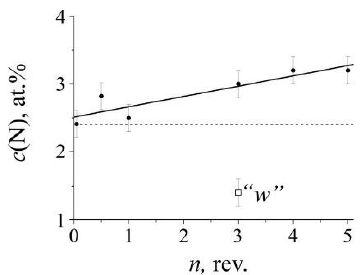
Figure 8. The dependence (tendency) of the nitrogen content c (N) in the austenite matrix on the degree of deformation n (number of revolutions n ) of the pre-aged FeMn 22 Cr 18 N 0.83 steel at 1073 K, 2 h. The dotted line indicates the nitrogen content in the aged steel; the point “ w ” indicates the nitrogen content after the HPT of n = 3 rev. at 298 K, for 30 min and subsequent annealing at 573 K, for 30 min.